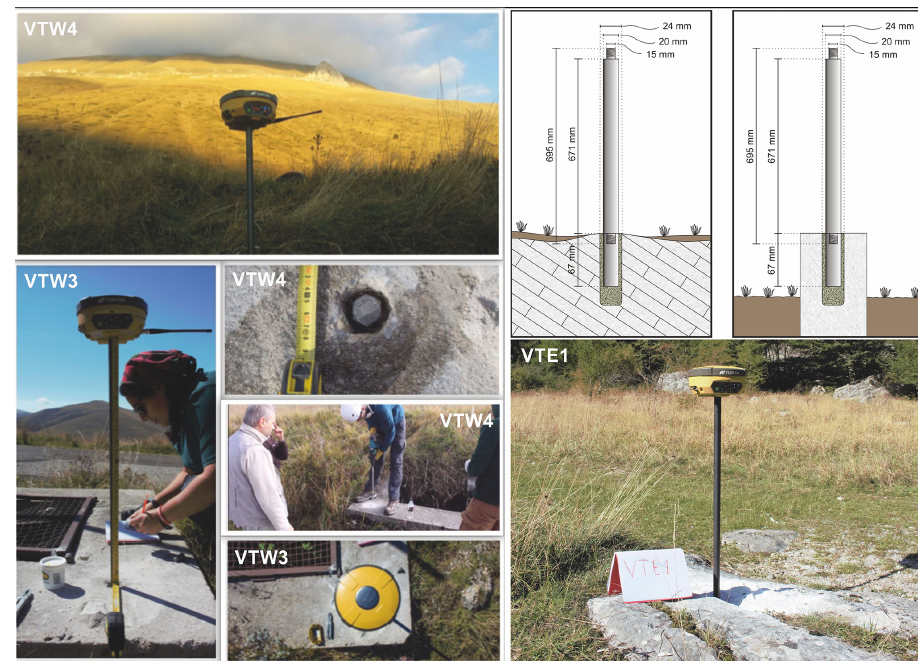
Figure 3. Synoptic picture showing installation of the new GNSS stations, measurement and processing phases.